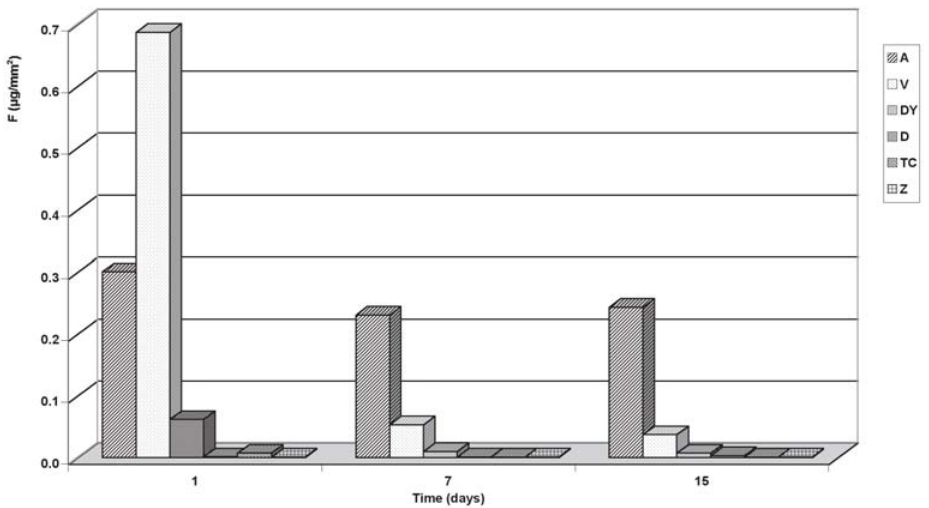
O, during 24 hours at the 1 st , 7 th and 15 th 2